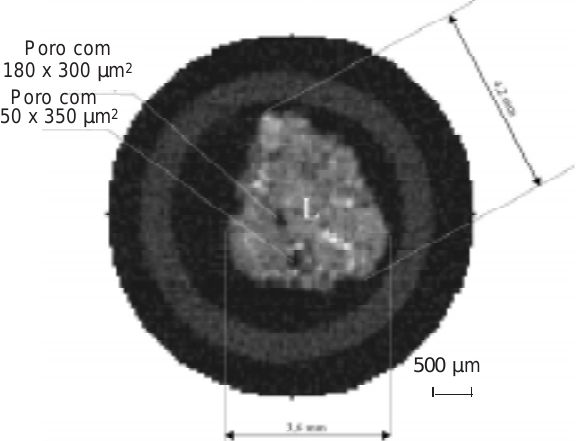
Figura 6. Tomografia de um torrão de Latossolo Vermelho-Escuro, onde podem ser vistos dois macroporos. O valor máximo de densidade das partículas encontrado foi de 2,991 g cm -3